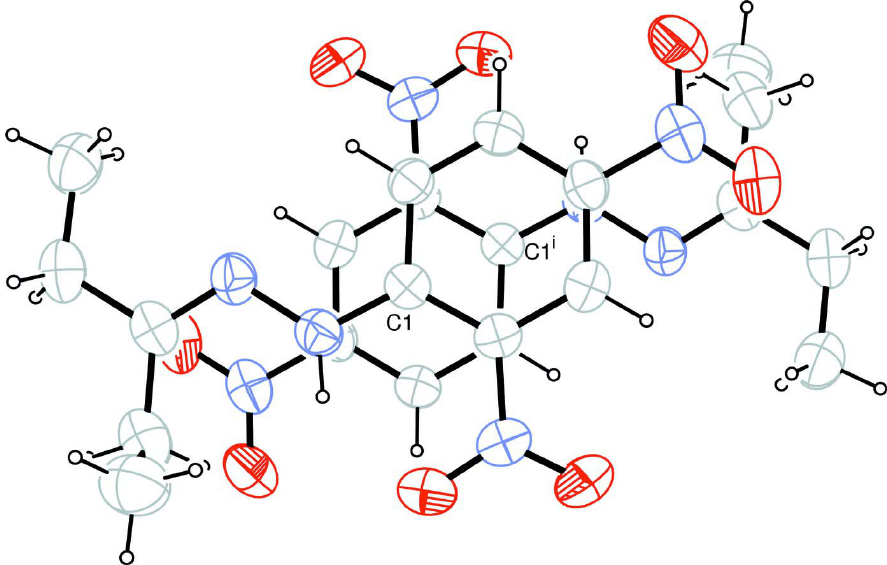
Figure 1 The molecular structure of the title compound with 30% probability displacement ellipsoids for non-H atoms, dashed line indicates hydrogen bonding.